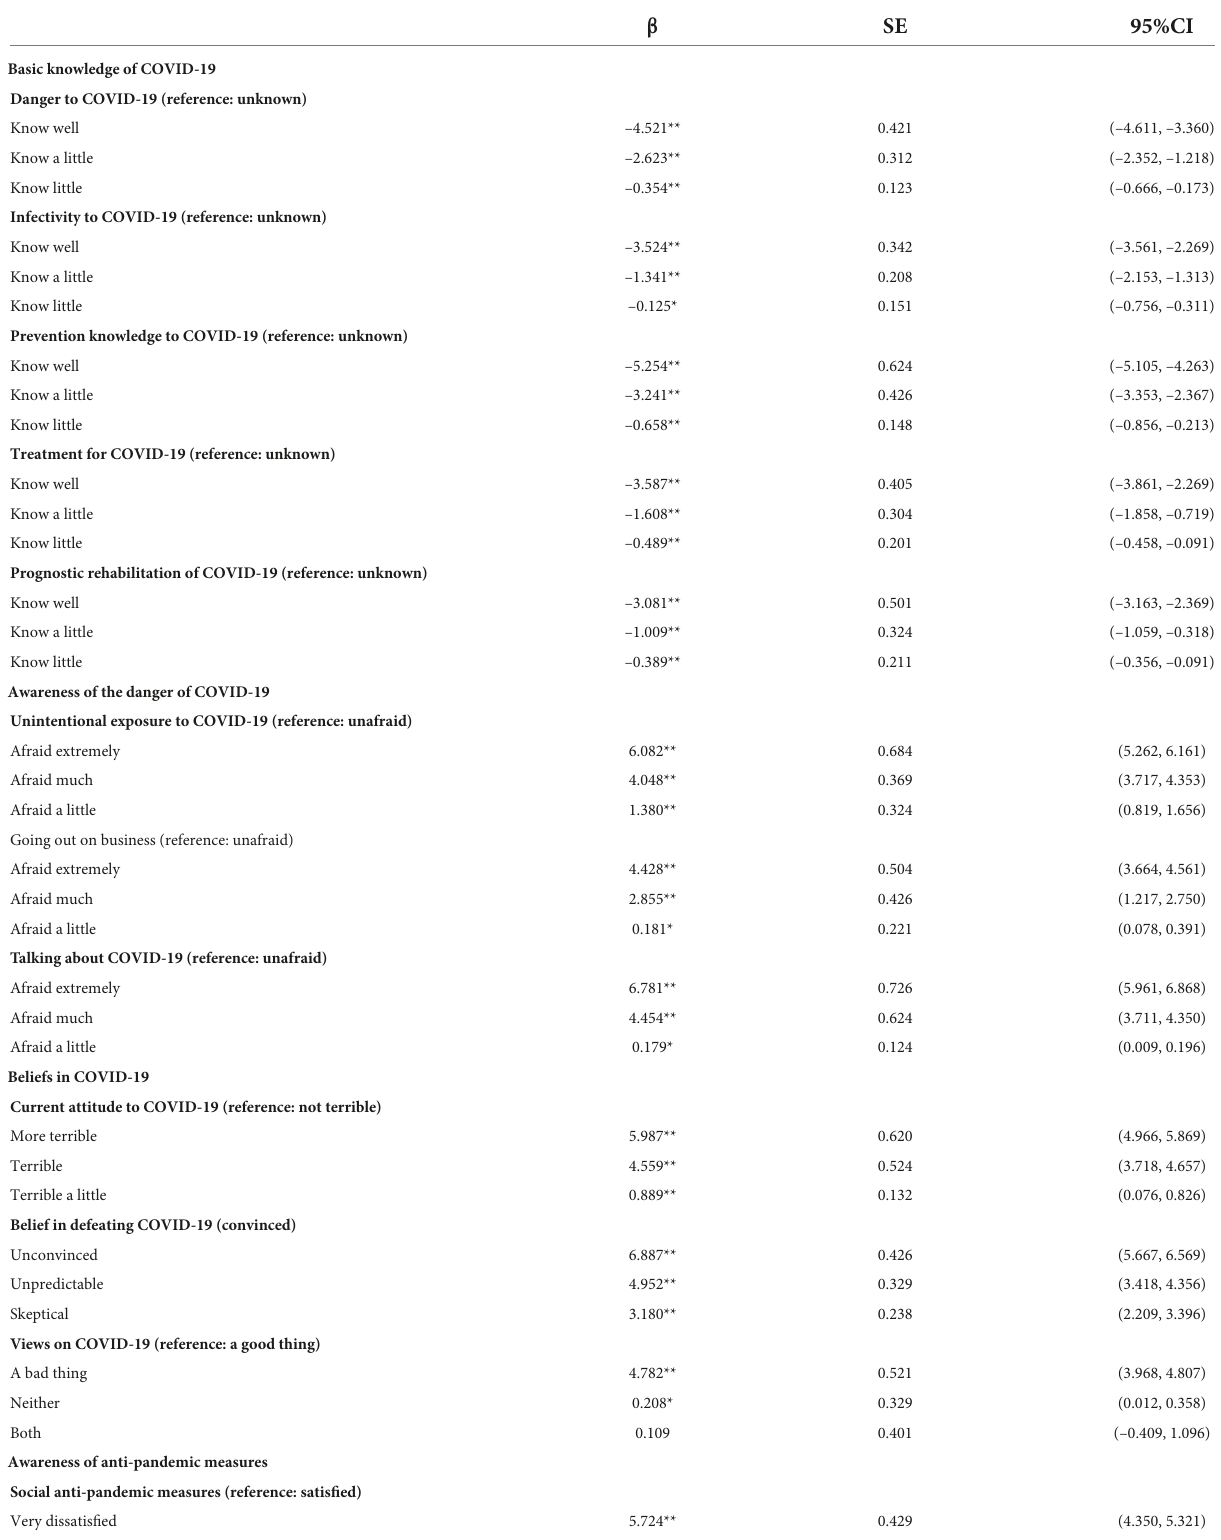
TABLE 9 Multiple regression analysis affecting the psychological state of college